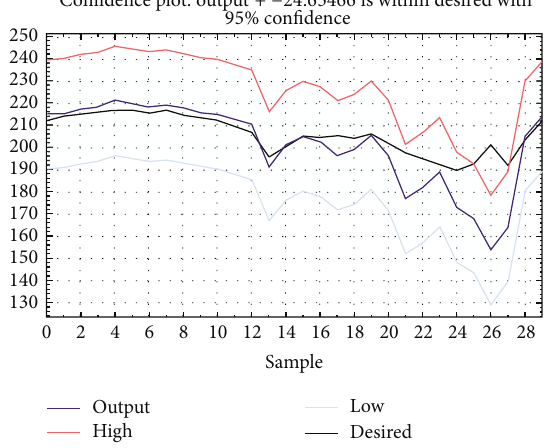
Figure 13: Calculated power output versus measured power output for the Sanyo module (MlP 1